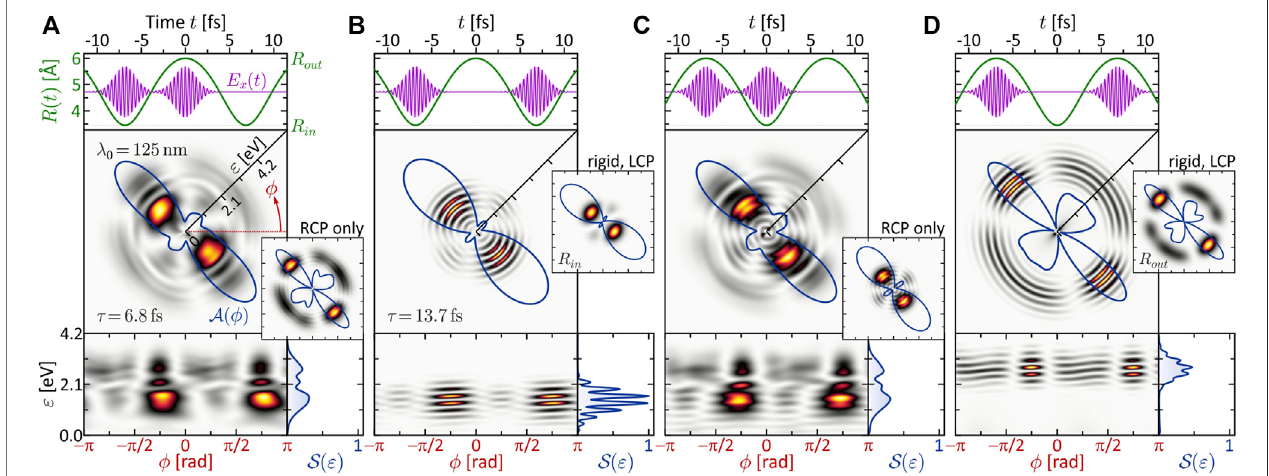
FIGURE 5 | One-photon ionization of the vibrating molecule by single-color LRCP sequences locked to the two turning points of the nuclear vibration R ( t ). The 2D PMD in energy representation P ( ε , ϕ ) is shown in Cartesian (central frames) and spherical representation (bottom frames). In addition, the energy-integrated angular distributions A ( ϕ ) areshownaspolarplots(bluecurves)andtheangle-integratedenergyspectra S ( ε ) areshowninthebottomrightframes.In (A,C) ,thetwosubpulses are locked to different turning points, while in (B) , both pulses ionize the molecule at the inner and in (D) at the outer turning point.